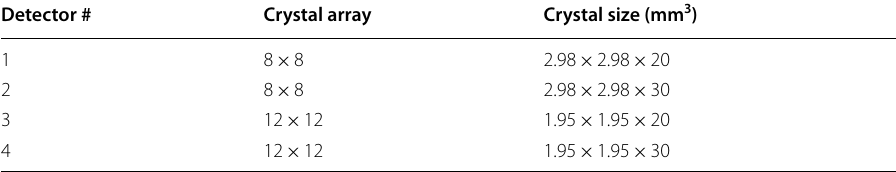
Table 1 Detailed information of the four LYSO arrays Detector # Crystal